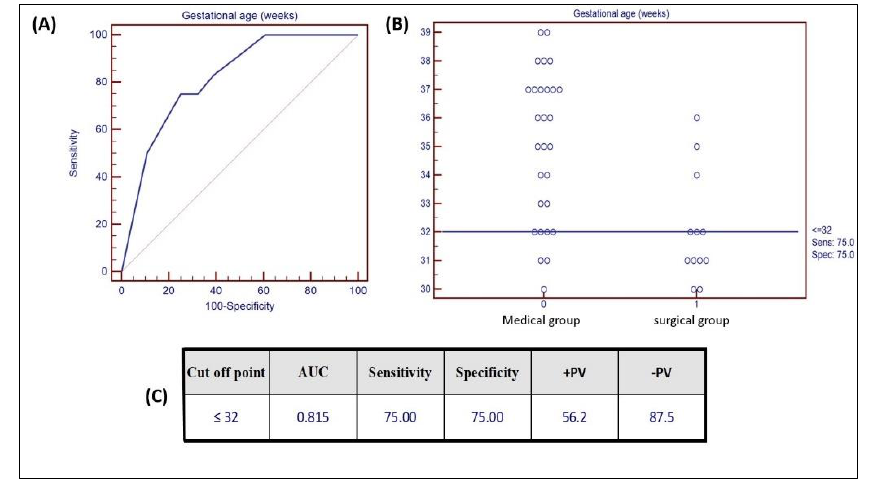
Figure 4: (A): Receiver operating characteristic curve (ROC) for gestational age (weeks) as a predictor to differentiate between medical and surgical cases; (B): Patient’s distribution according to the gestational age (weeks) in both groups; (C): Area under the curve (AUC), sensitivity and specificity of the cutoff